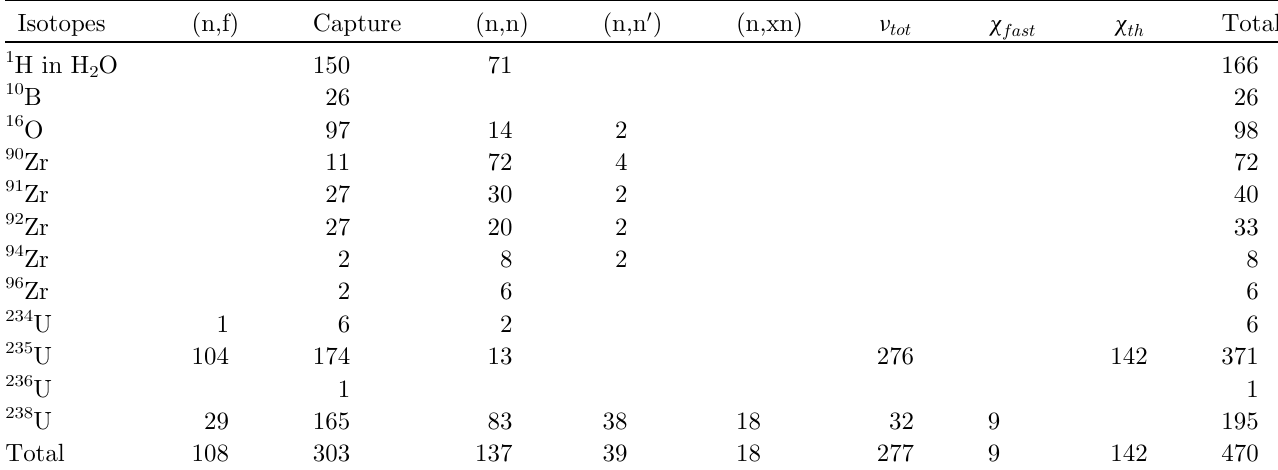
Table 6. Example of uncertainties on the reactivity (UOX con fi guration at room temperature) in pcm due to the nuclear O comes from the present work. The other contributions were calculated with the data. The contribution of 1 H in H 2 covariance data base COMAC [32] developed at the CEA of